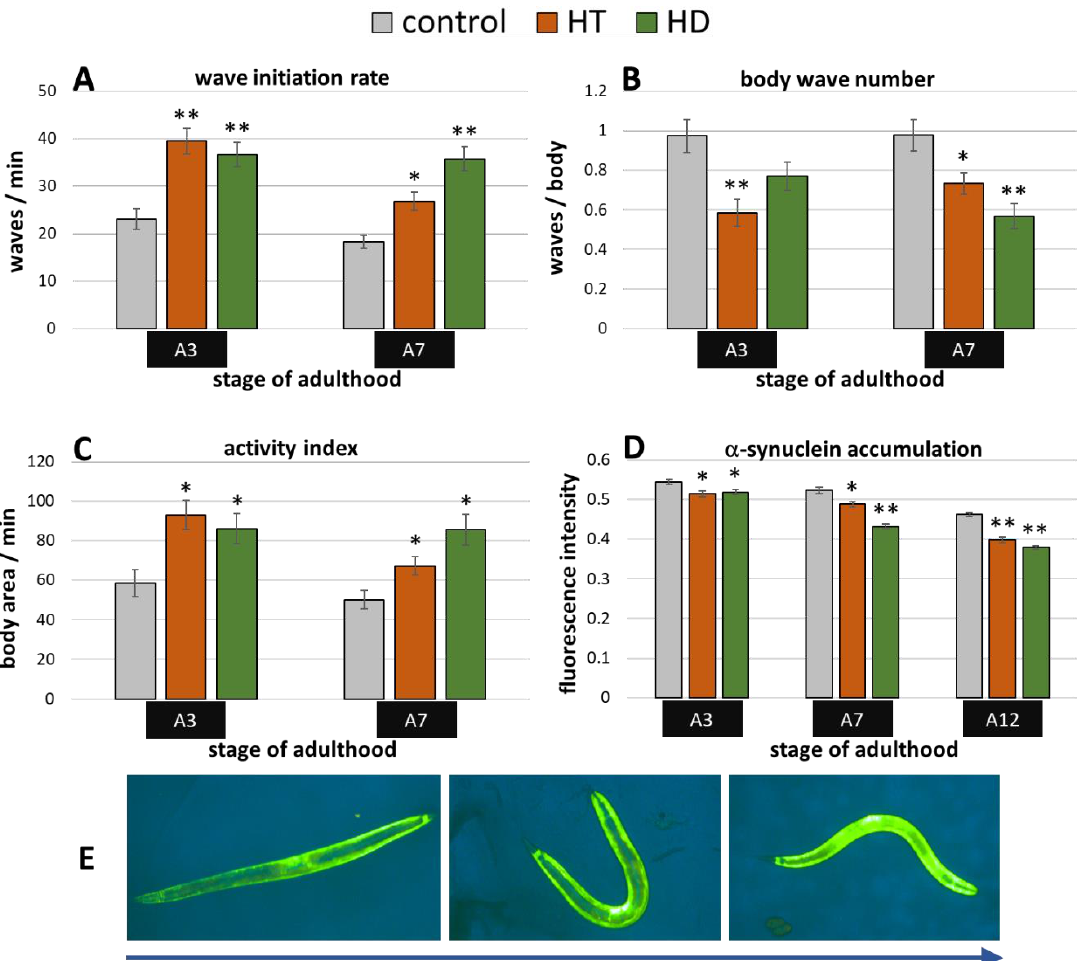
Figure 5. Benefits from HD & HT treatment in the OW13 strain. The nematode strain OW13 is characterized by α-synuclein expression in the body wall muscle cells. After polyphenol treatment, the wave initiation rate ( A ), the body wave number ( B ) and the activity index ( C ) were determined in two independent trials with ≥51 nematodes per treatment and age. Furthermore, the α-synuclein accumulation in muscle cells was quantified in two trials with ≥35 nematodes per treatment and age by fluorescence microscopy using a yellow filter ( D ). Data are presented as mean ± SEM. Differences compared to control were considered significant at p < 0.05 (*) and p < 0.001 (**). A3, A7, A12: 3rd, 7th and 12th day of adulthood. Finally, examples for the appearance of α-synuclein accumulation with increasing fluorescence intensities are shown ( E ).